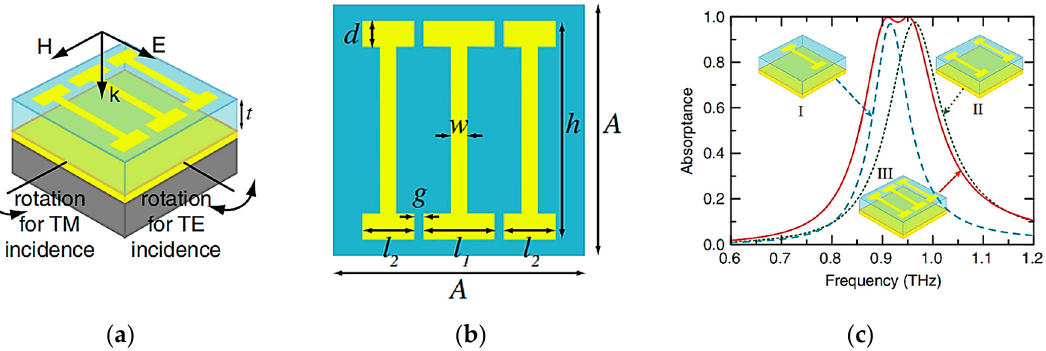
Figure 16. The whole unit cell of the Terahertz broadband absorber [54]. ( a ) Schematic of the whole unit cell; and ( b ) top view of the metamaterial absorber with dimensions. ( c ) Numerical simulation results of absorption spectra at normal incidence for three different configurations of the I-shaped resonators.